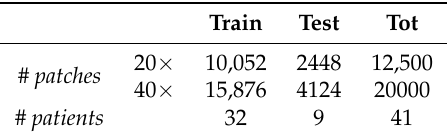
Table 1. Colorectal image dataset. Characterization of the independent sets used for training and testing purposes.